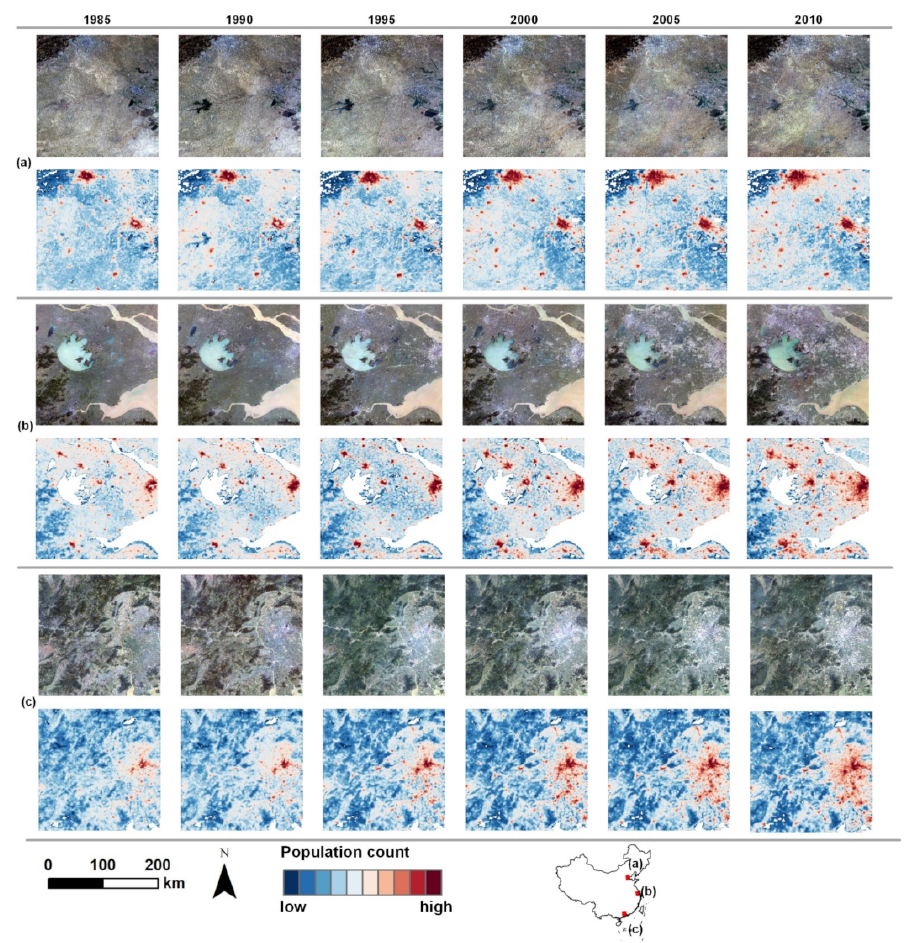
Figure 15. Population distributions ( bottom row ) and landscape variations ( top row ) of three regions in large urban agglomerations in China from 1985 to 2010. ( a ) Beijing-Tianjin-Hebei; ( b ) The Yangtze River Delta; ( c ) The Pearl River